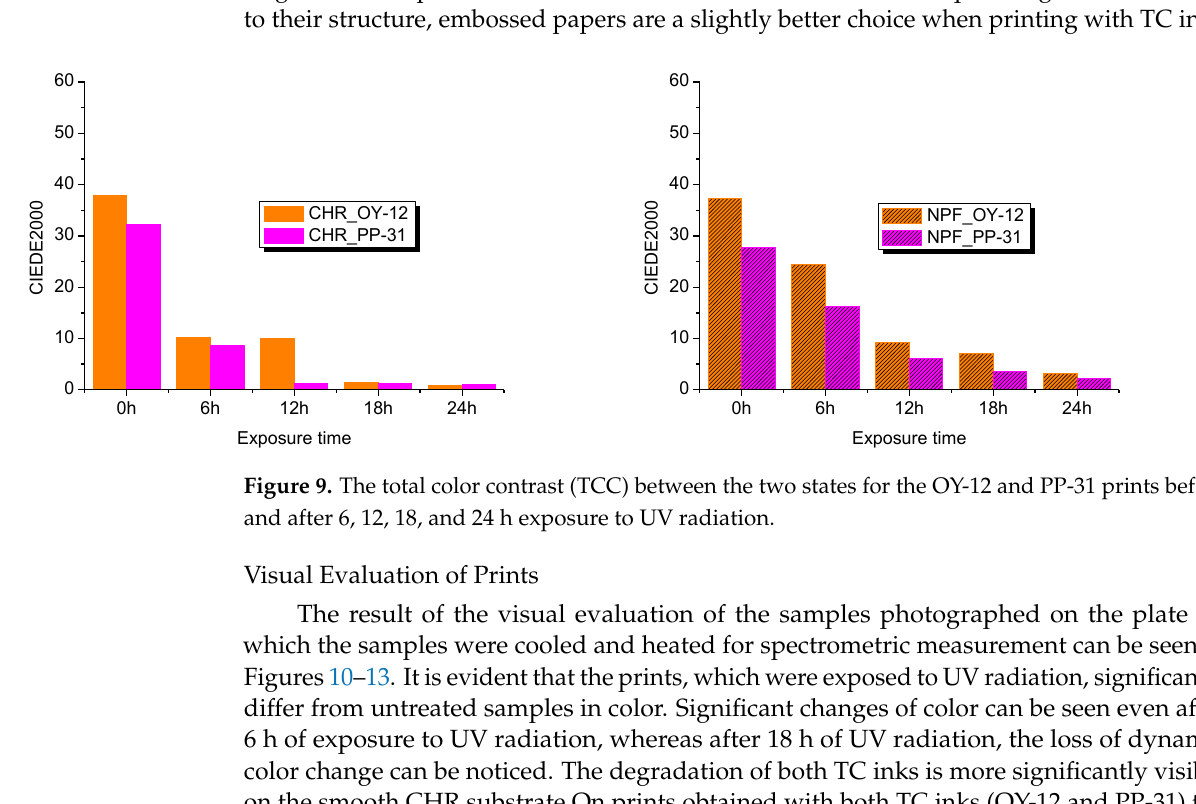
Figure 11. Visual presentation of thermochromic prints of cold activated TC ink OY-12 at 20 °C, before and after exposure of samples to UV radiation (6, 12, 18, and 24 h) (above CHR sample, below NMF sample). Figure 12. Visual presentation of thermochromic print of heat activated TC ink PP-31 at 20 °C, before and after exposure of samples to UV radiation (6, 12, 18, and 24 h) (above CHR sample, below NMF sample). Figure 13. Visual presentation of thermochromic print of heat activated TC ink PP-31 at 45 °C, before and after exposure of samples to UV radiation (6, 12, 18, and 24 h) (above CHR sample, below NMF sample). 4. Conclusions The main task of thermochromic inks is to influence the experience of the message or design printed with them through their dynamic color change. Their role can be informa- tive or just creative. By analyzing some factors affecting the degradation of TC prints, that is, the dynamics of color change, an insight into the weaknesses of this complex mixture was provided. All tested TC prints showed low resistance to liquid chemical agents as color differ- ence values were unacceptable in all cases and bleeding of the colorants was detected as well. It was noticed that the stability of TC prints towards different chemicals decreases with decreasing solvent polarity, and the poorest stability was observed in the case of prints’ exposure to a 96% ethanol solution. Prints obtained with body-heat activated TC